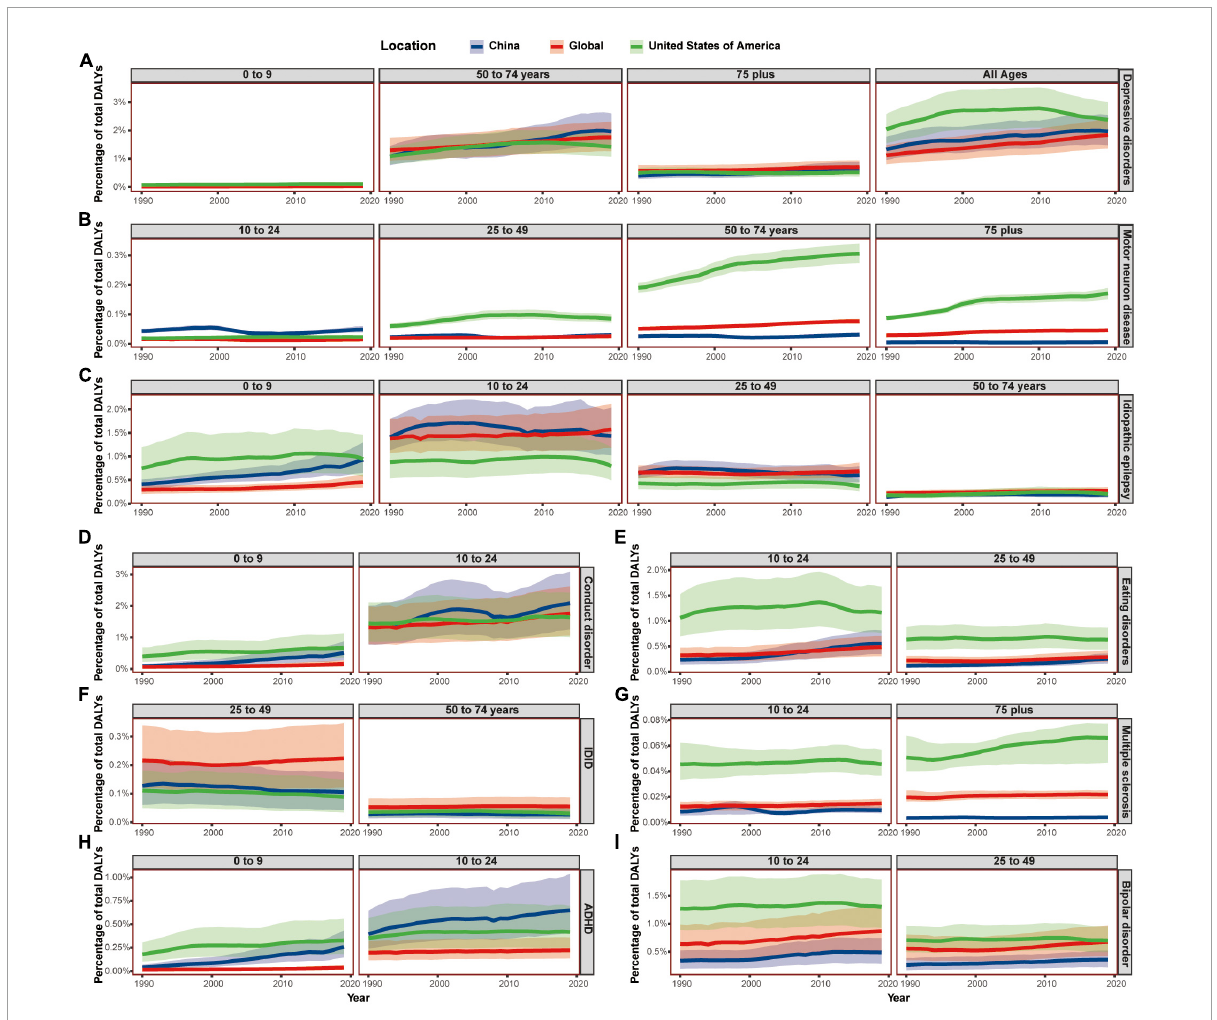
FIGURE4 The burden of depressive disorders and other neurological and mental disorders, by age groups. (A) Showed the DALY percentage of depressive disorders; (B) showed the DALY percentage of motor neuron diseases; (C) showed the DALY percentage of idiopathic epilepsy; (D–I) showed the DALY percentage of conduct disorders, eating disorders, Idiopathic developmental intellectual disability, multiple sclerosis, attention-deficit/hyperactivity disorder, and bipolar disorders, respectively. Shaded sections indicate 95% uncertainty intervals. DALYs, disability-adjusted life-years; IDID, idiopathic developmental intellectual disability; ADHD, attention-deficit/hyperactivity